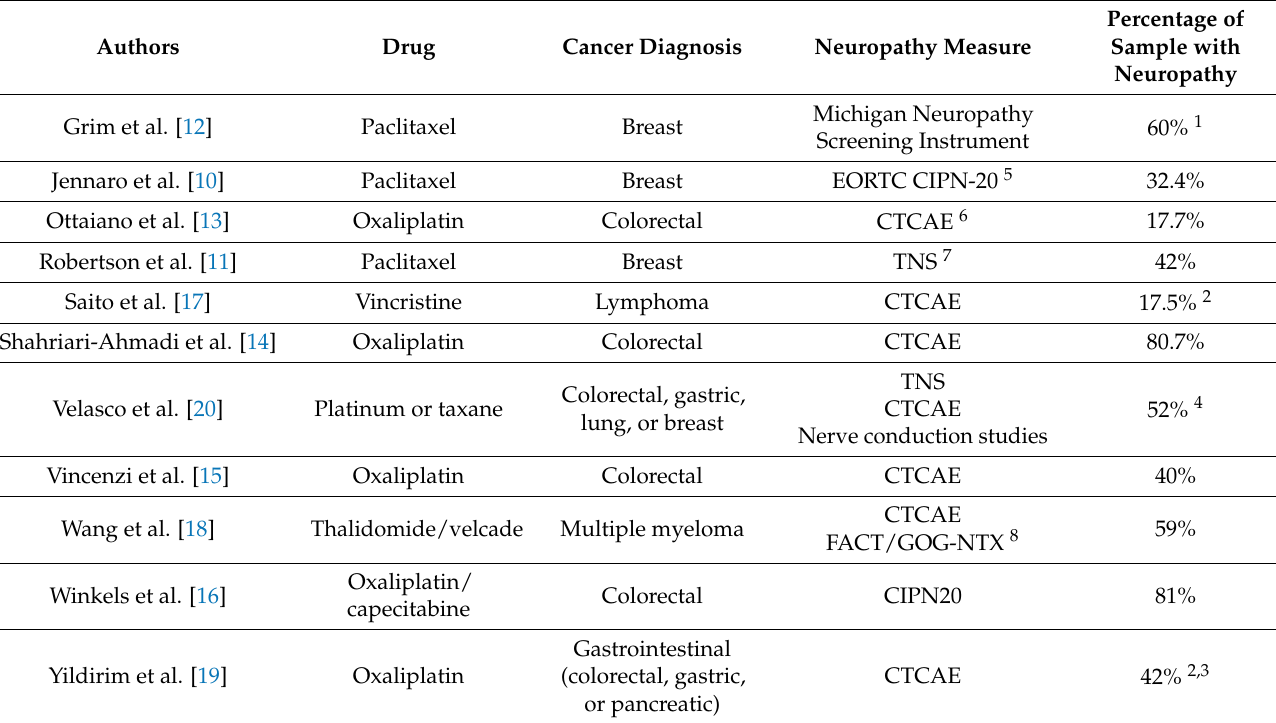
Table 1. Summary of included studies.